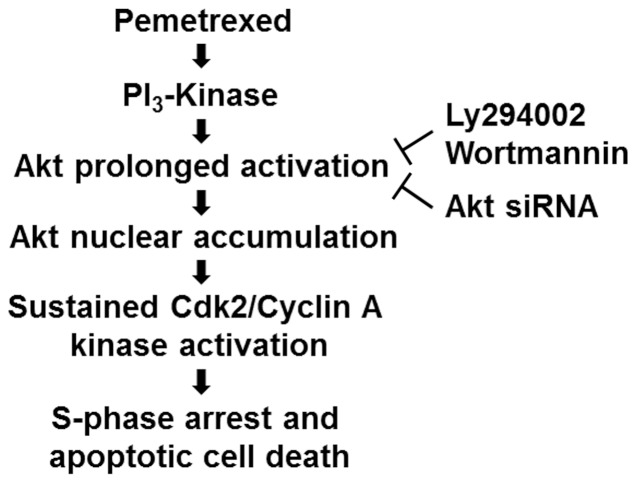
Schematic representation of the molecular mechanisms of pemetrexed-induced growth arrest and cell death in human NSCLC cell lines.